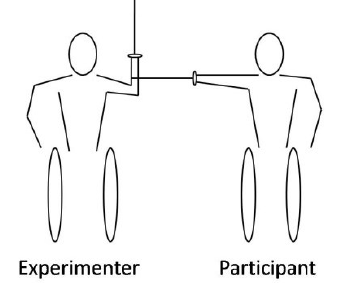
shoulder of the fencing arm and the lilac crest of the fencing arm (line SH), and (b) the vertical line perpendicular to the ground that went through the hip joint (line HX). Although the internal consistency of the assessments of maximum lunge velocity (  = .94;  = .86), WFC competition maximum lunge angle (  = .89;  WFC competition = .85), maximum fast-return velocity (  = WFC EUJAPA, Vol. 6, No. 1